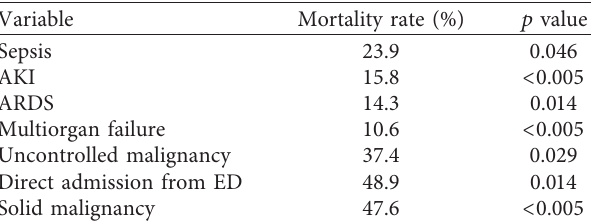
Figure 1: Overall survival. Table 2: Univariate analysis of ICU outcome.